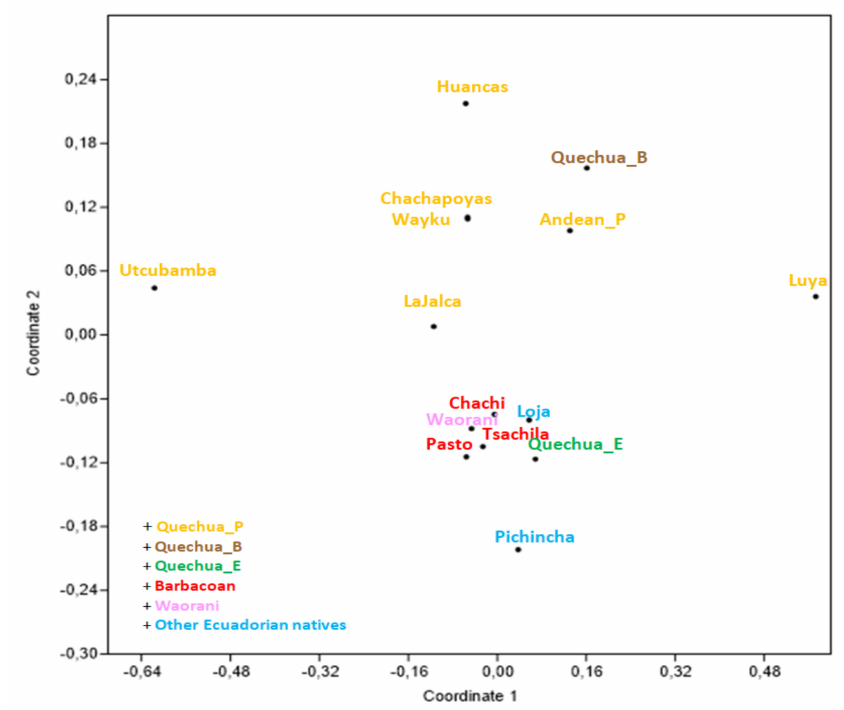
Figure 3. MDS plot based on ϕ st genetic distances (stress value = 0.093) among 15 Ecuadorian, Peruvian, Bolivian, and Colombian